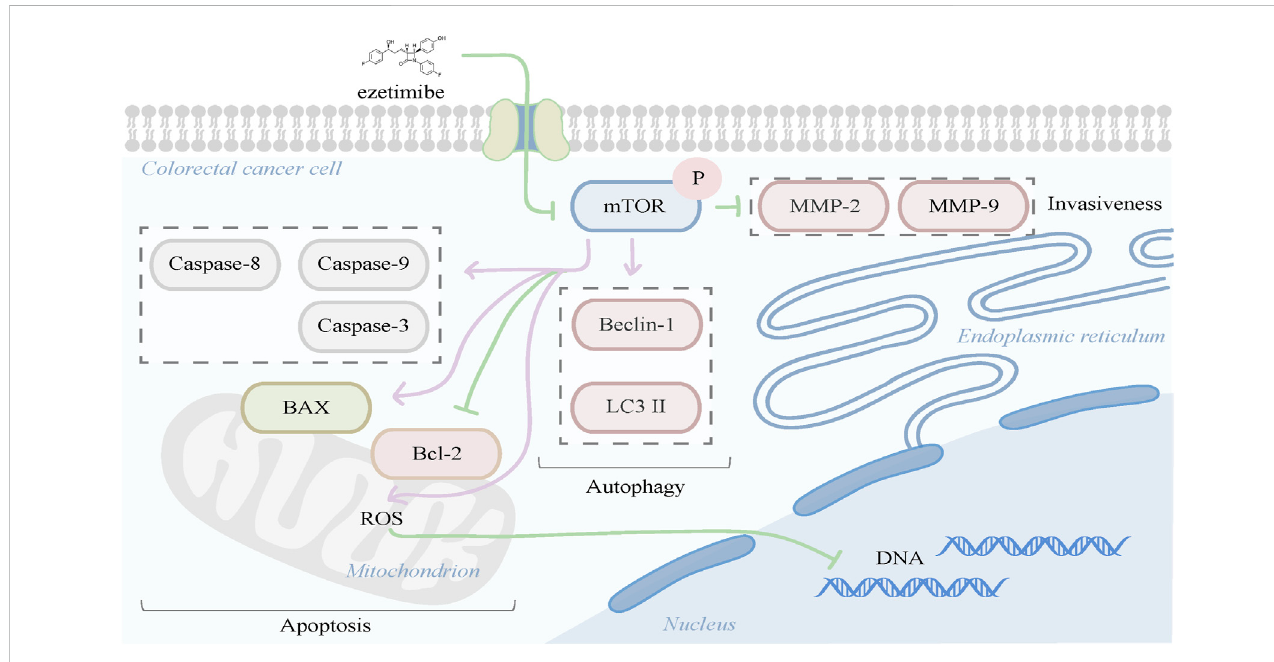
FIGURE 7 Ezetimibe induced colorectal cell death were found to be correlated with mTOR signaling-dependent mitochondrial dysfunction in apoptosis promotion, meanwhile presented effects of autophagy activation and invasiveness